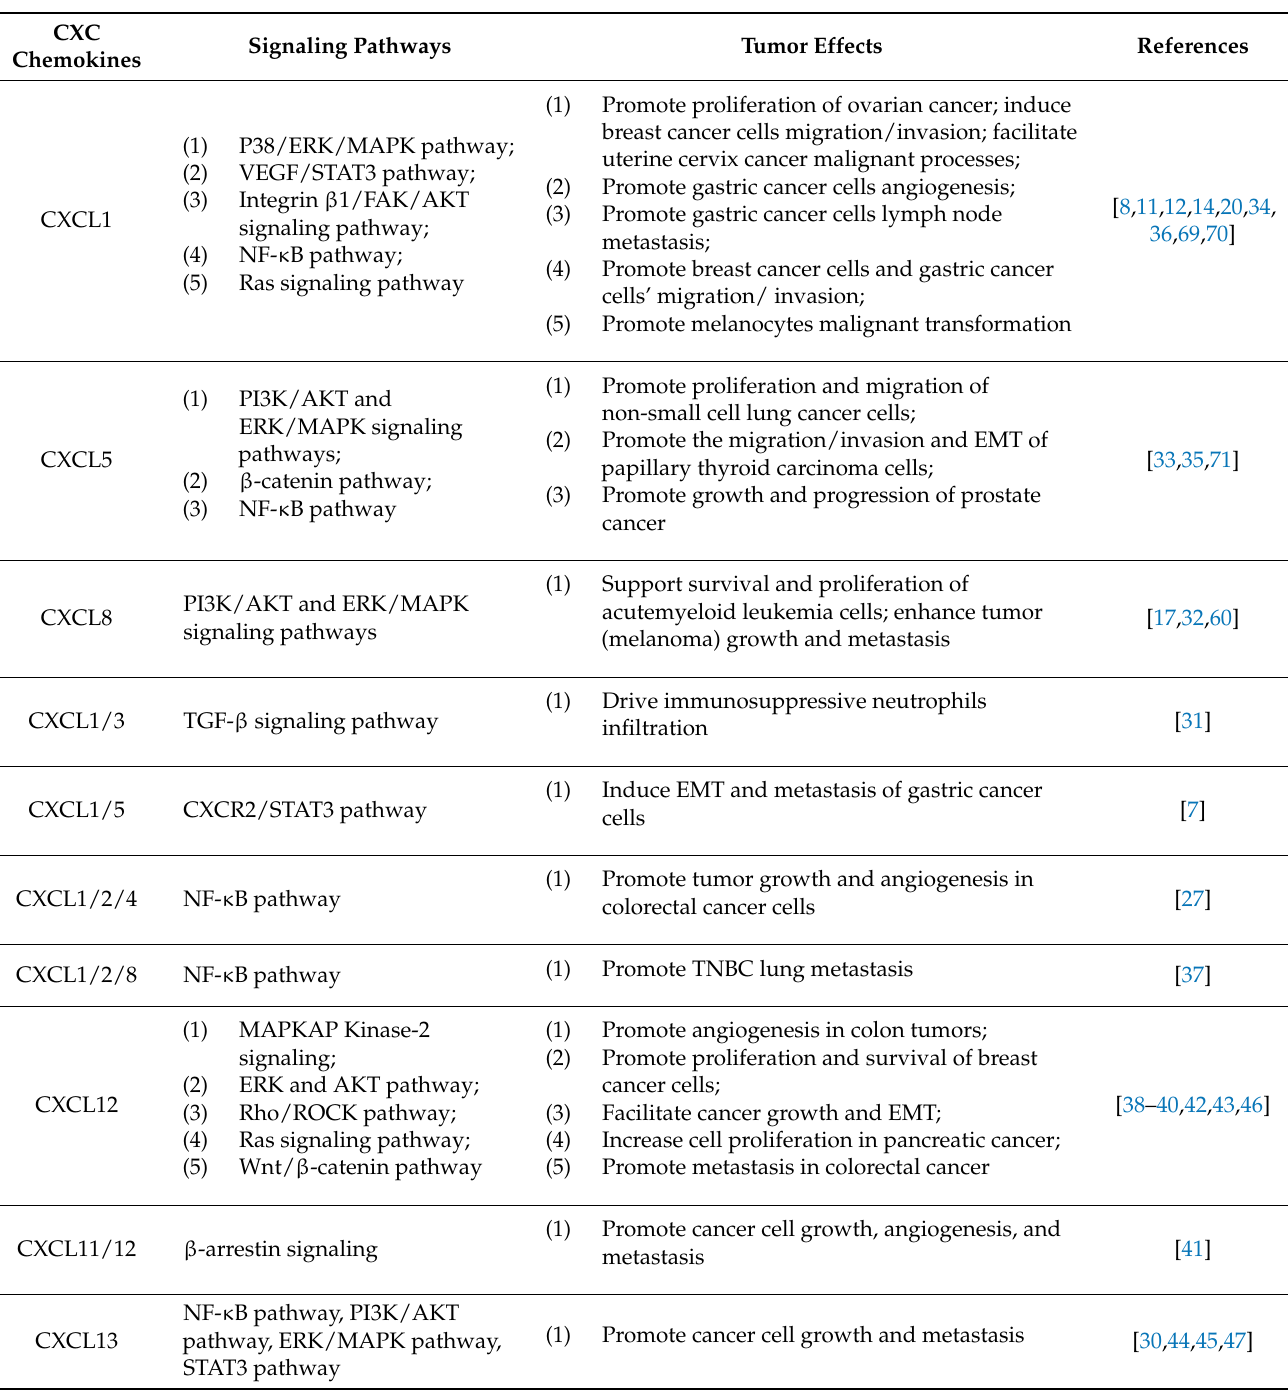
Table 2. Corresponding signaling pathways and tumor effects of CXC